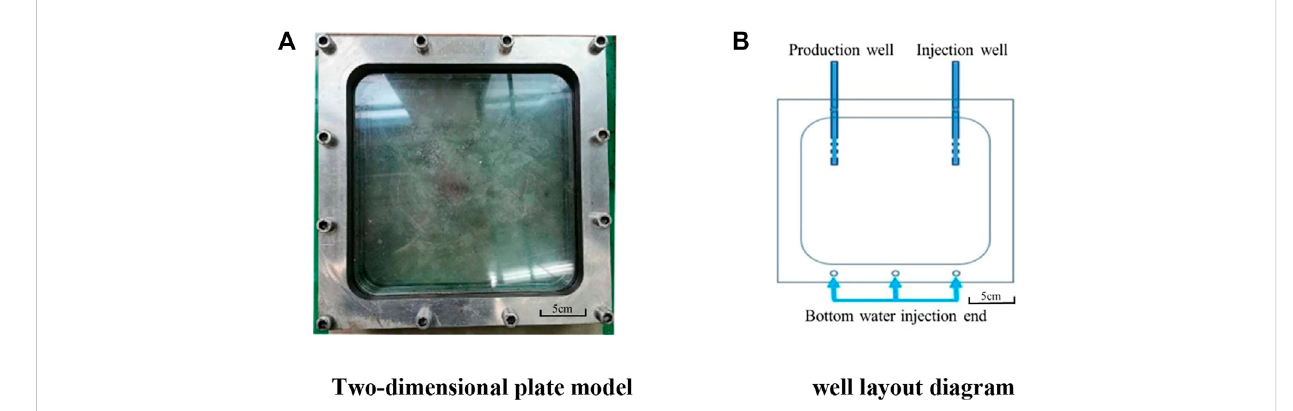
FIGURE 6 (A) Two-dimensional plate model and (B) well layout diagram.